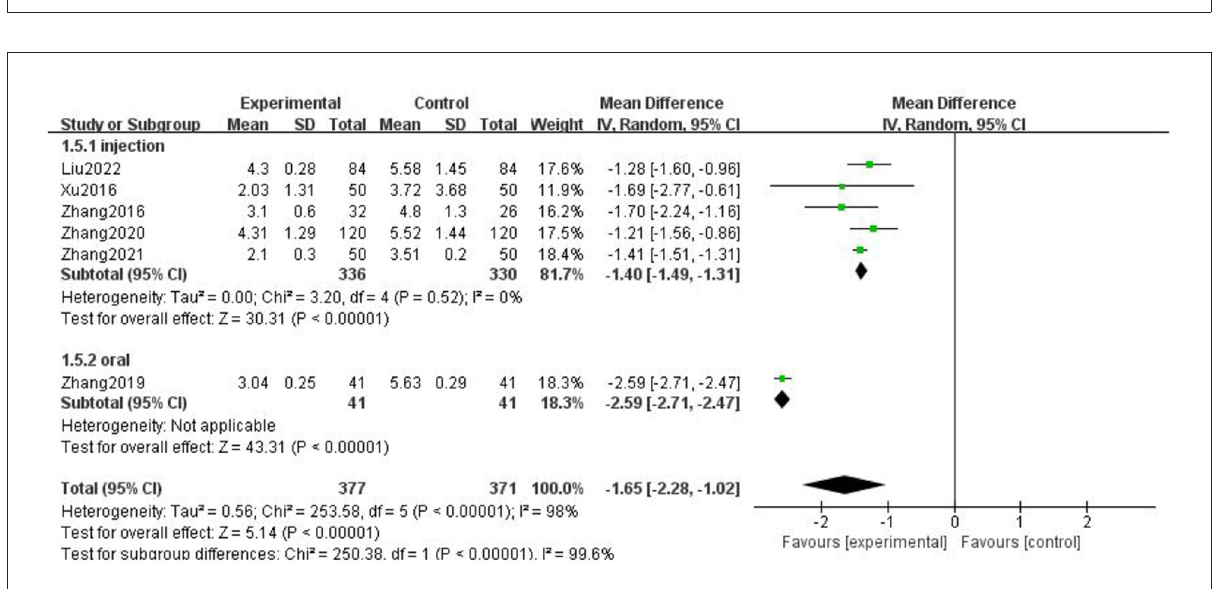
FIGURE6 Forest chart of headache score divided into subgroups according to medication